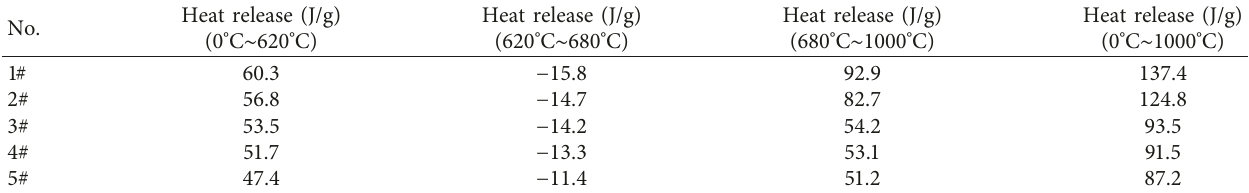
Table 4: The parameters for different processes of heat release in the DSC